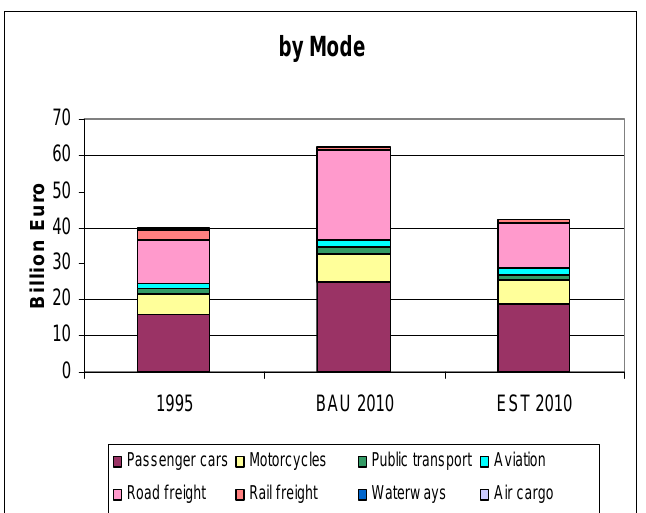
Figure 9. External Costs of Transport in the CEI Region for BAU and